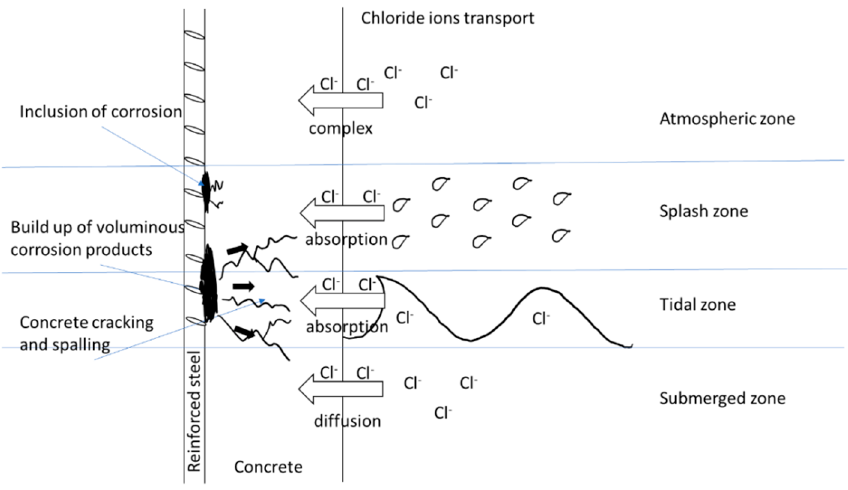
Figure 1. Corrosion process caused by an aggressive chloride environment.